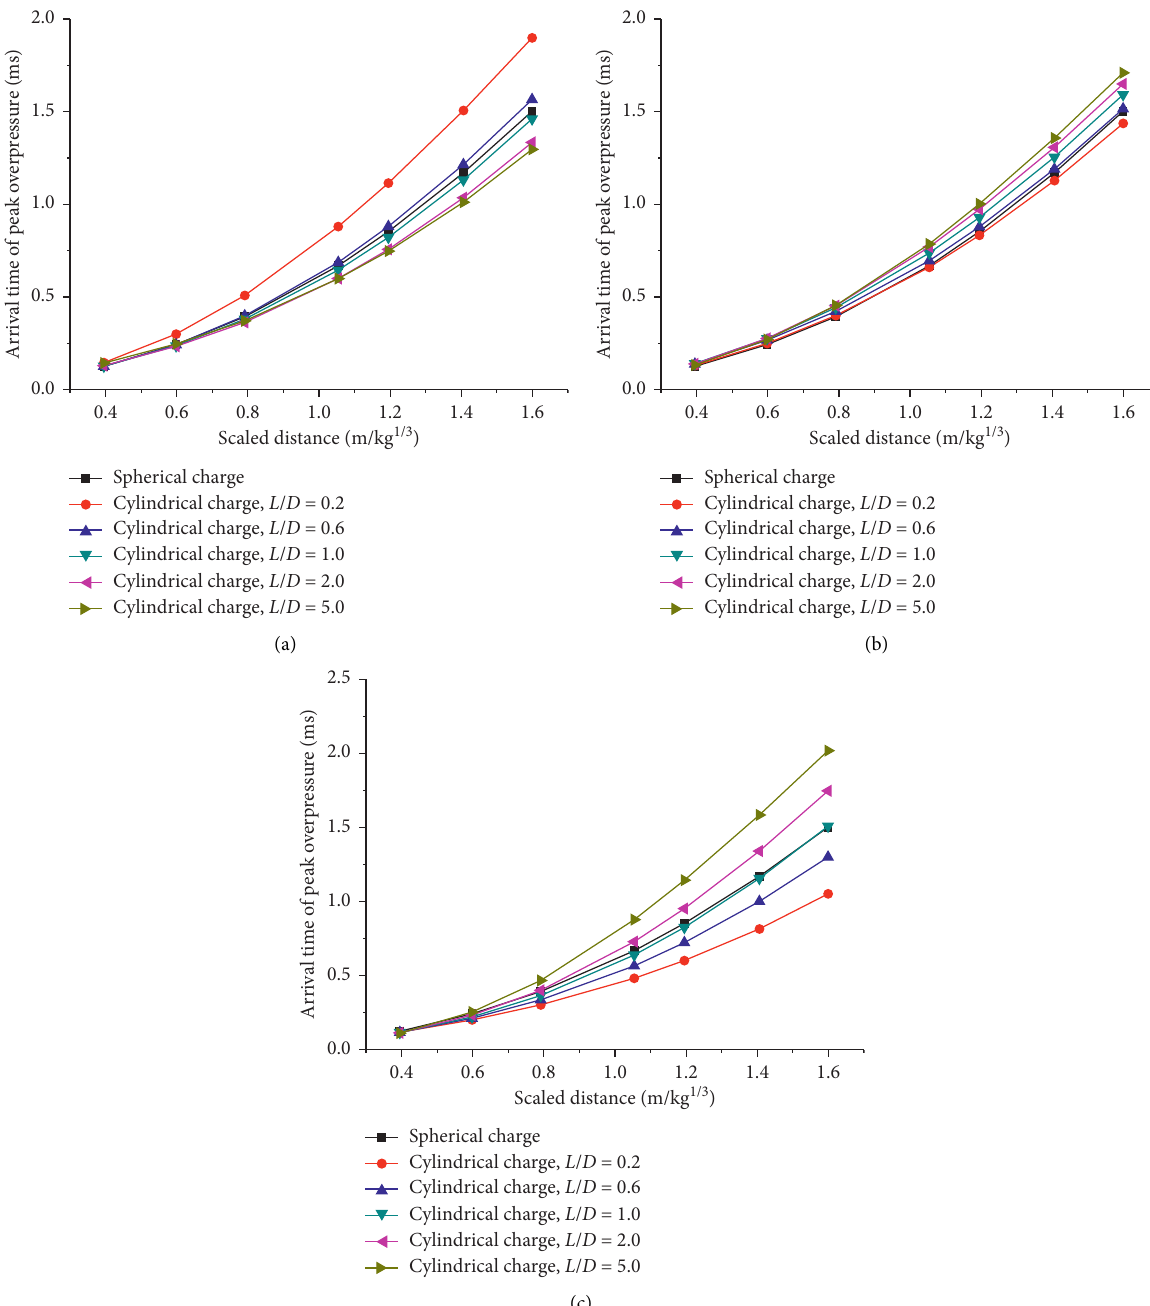
Figure 8: The arrival time of the peak overpressure. (a) Radial direction. (b) 45 ° direction. (c) Axial